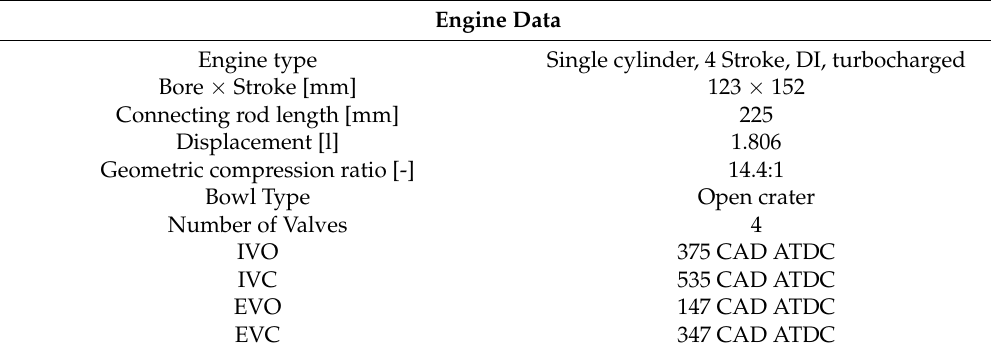
Table 1. Single cylinder engine